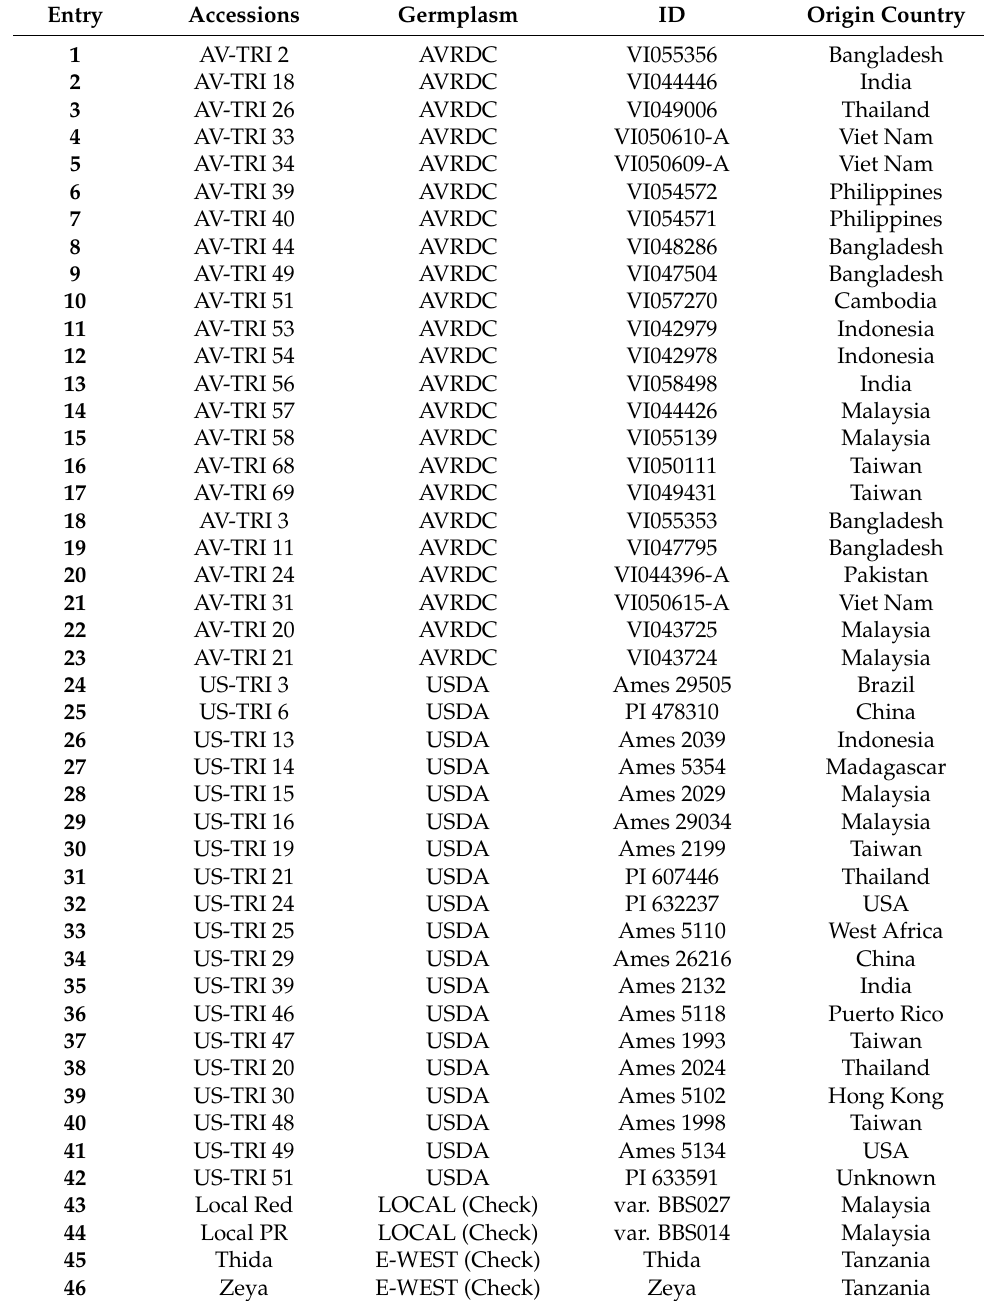
Table 1. List of plant materials used for drought tolerance in two screening